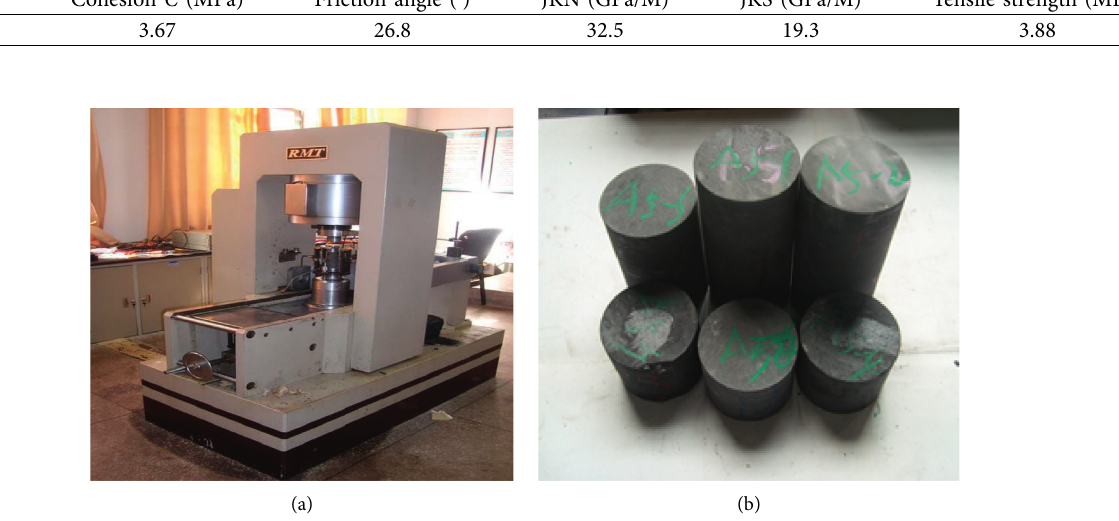
Figure 2: Test equipment and rock samples. (a) Test equipment. (b) Sandstone sample.